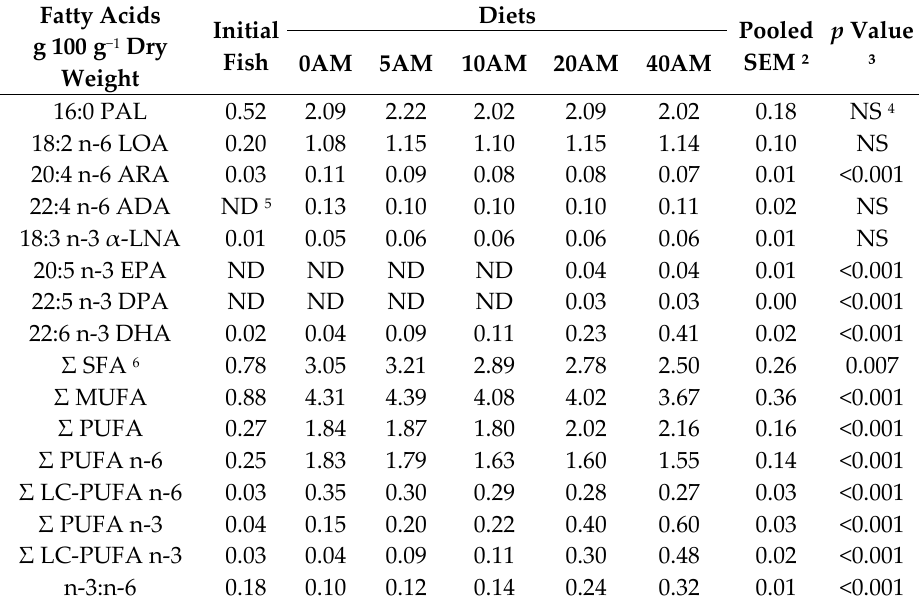
Table 2. Whole body fatty acid composition of Nile tilapia juveniles fed increasing concentrations of Aurantiochytrium sp. meal (AM) for 87 days, at 22 °C ¹.